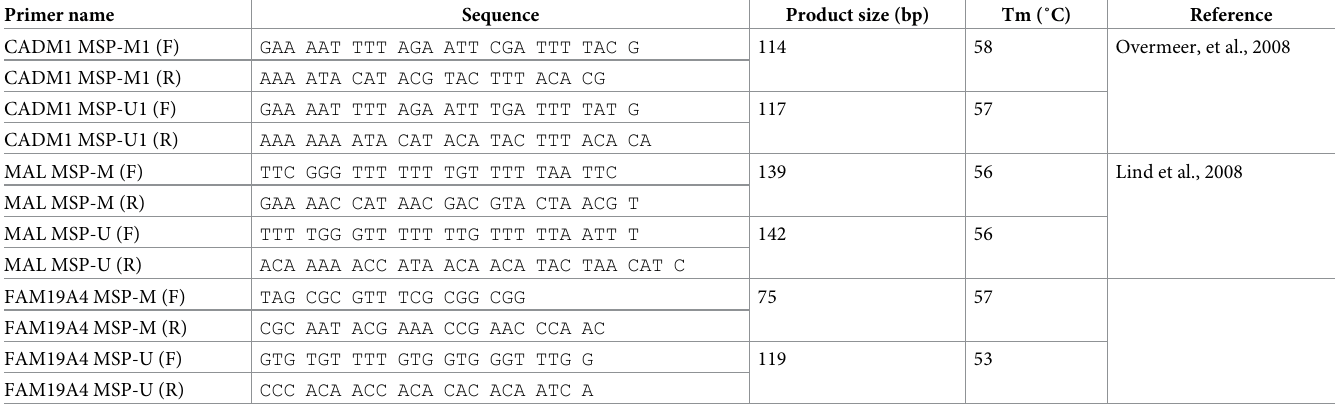
Table 2. The primer sets for methylation specific